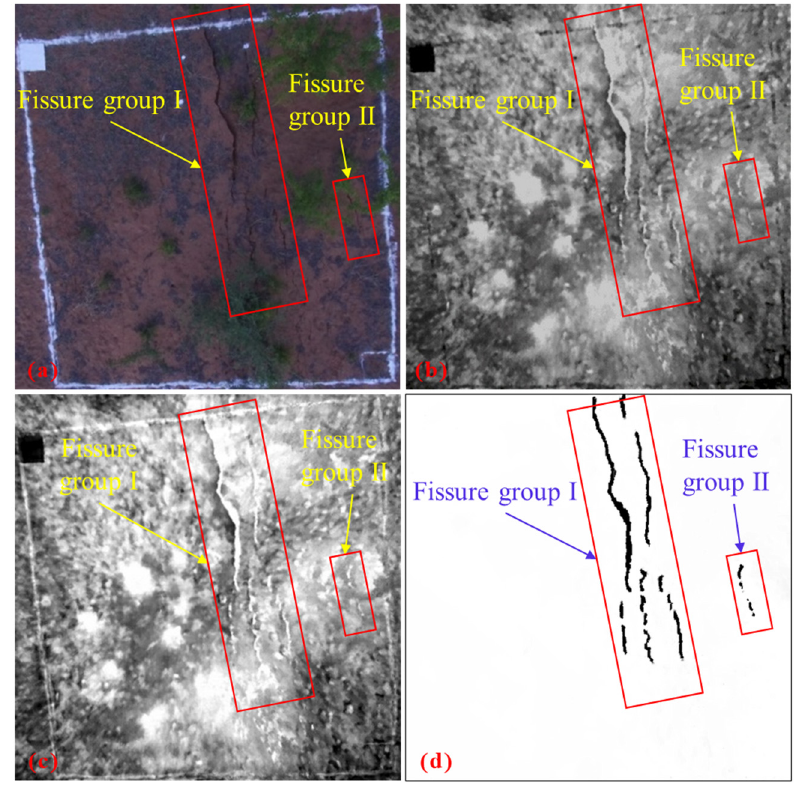
Figure 6. Mining-induced ground fissures (marked with the red squares) in the ( a ) infrared image, ( b ) visible image, ( c ) fused image using CVT-SR, ( d ) ground truth image. ( b ) visible image, ( c ) fused image using CVT-SR, ( d ) ground truth